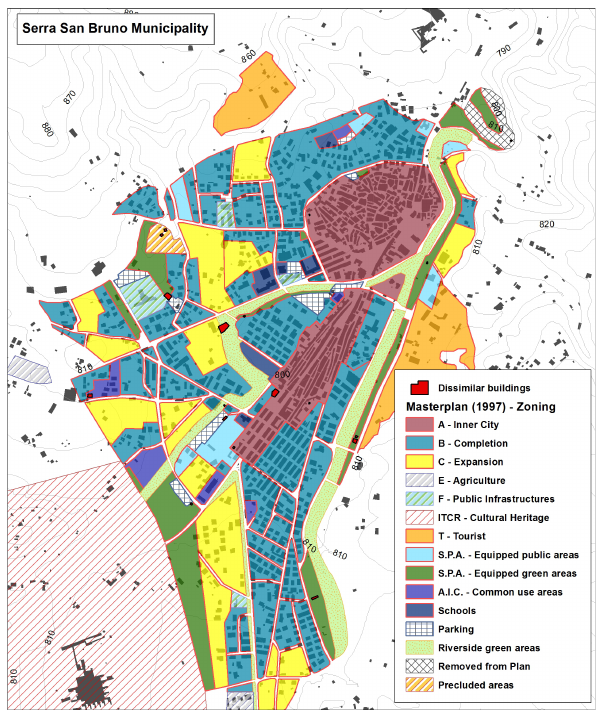
Fig. 7. Analysis of the General Master Plan adopted in 1997, in force until 2007 and currently being